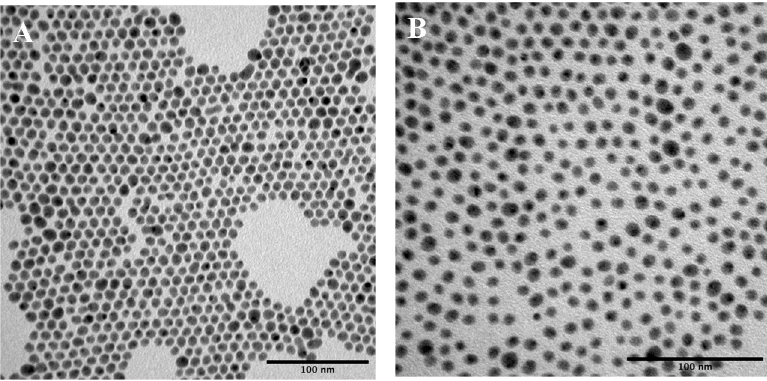
Figure 1. Representative TEM images for ( A ) Ag 2 S@DDT and ( B ) Ag 2 S@SH-PEG-OCH 3 NPs .